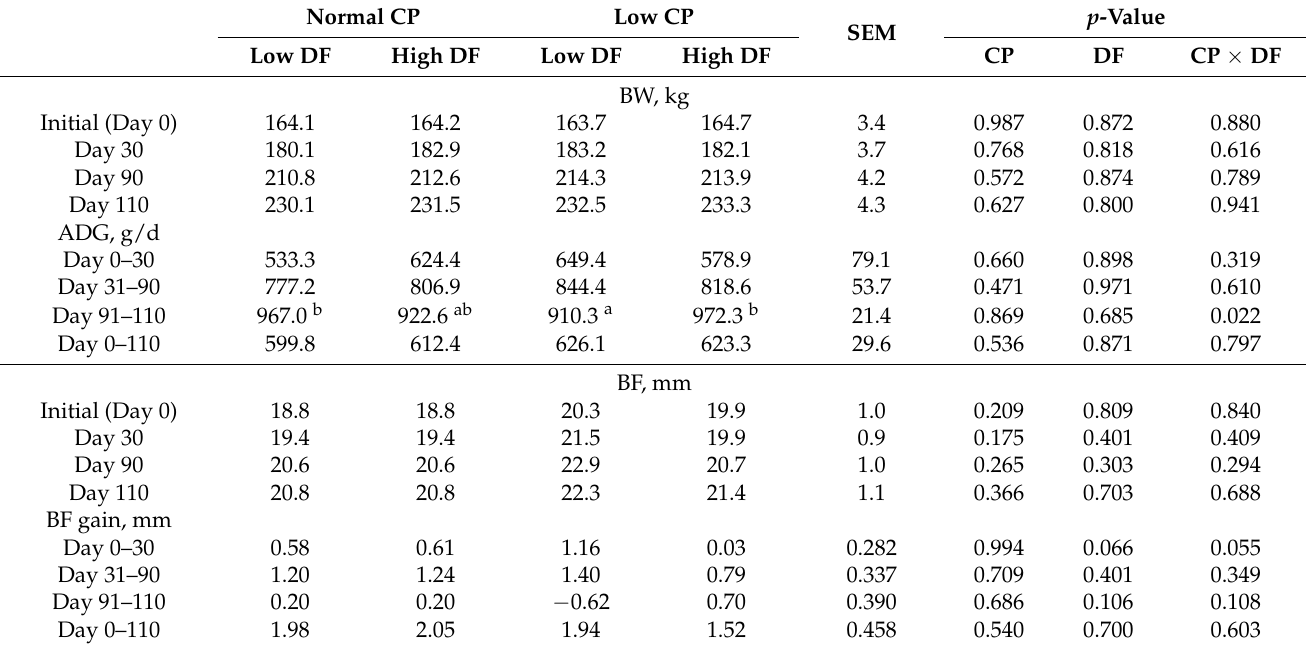
Table 2. Effects of dietary treatments on the growth traits of gestating sows.